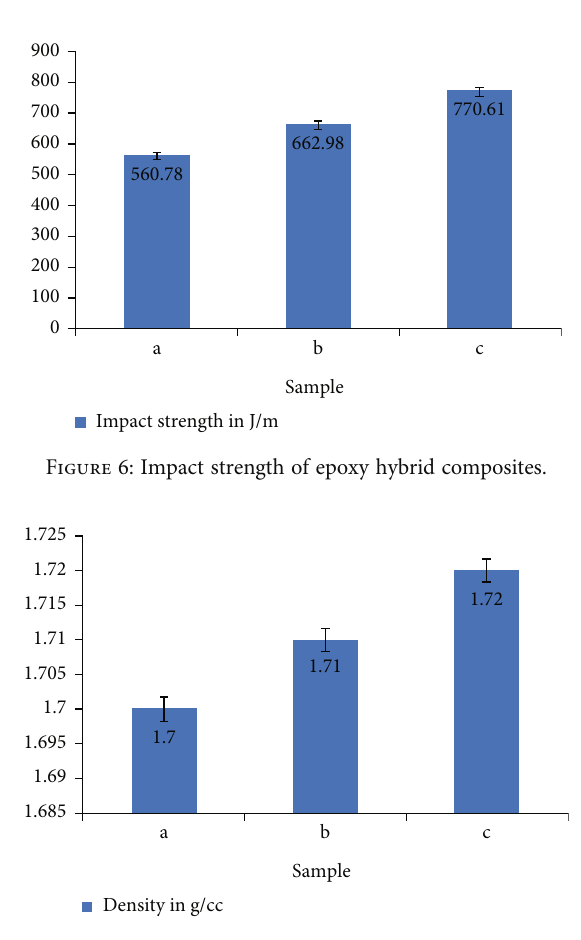
Figure 7: Density of epoxy hybrid composites.